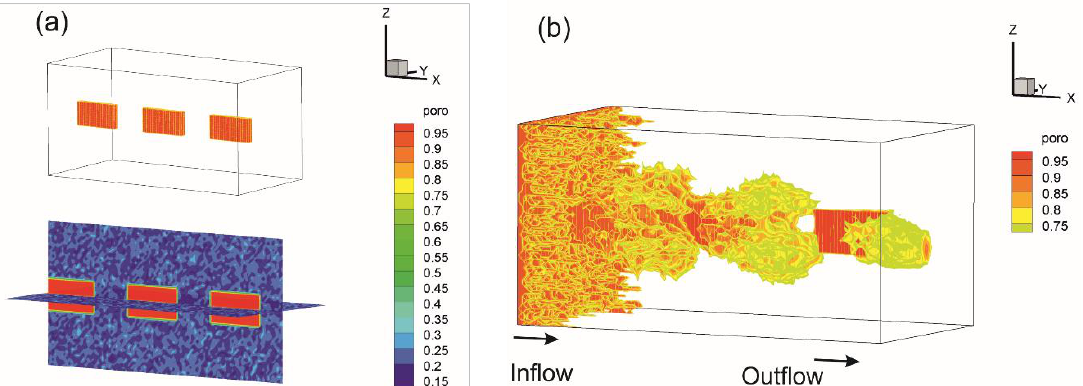
Figure 6. Porosity profile of fractured rock with fluctuations in the interval [−0.10, 0.10]. ( a ) Initial condition; ( b ) dominant wormhole.